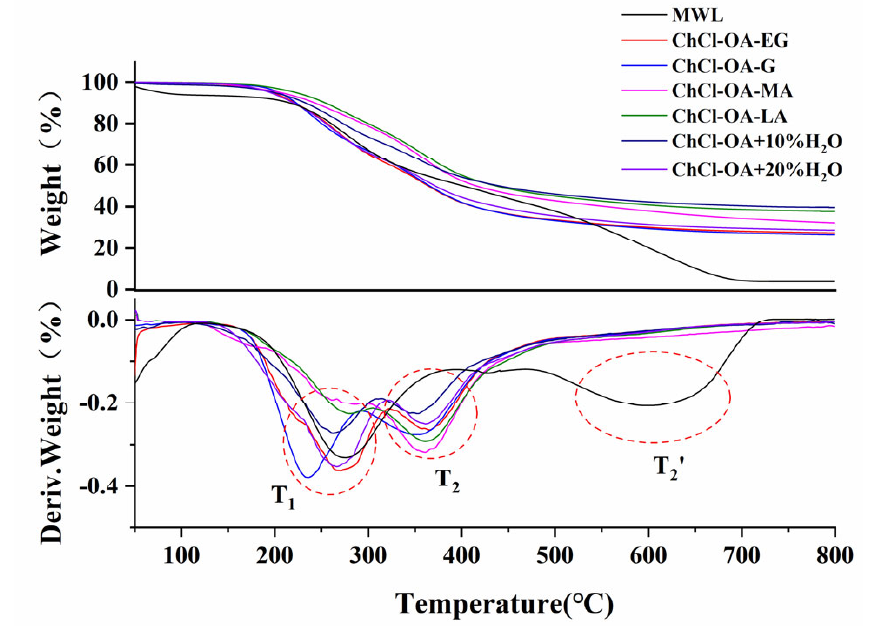
Figure 8. TG/DTG curves of different DES − Ls.